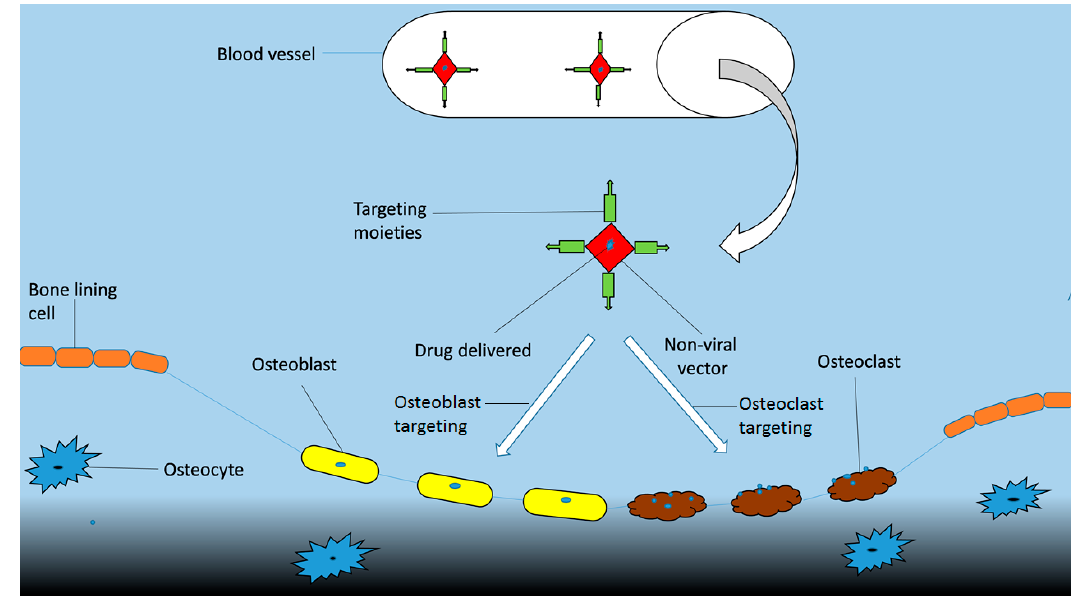
Figure 5. Scheme of delivery of bone cell specific drugs.